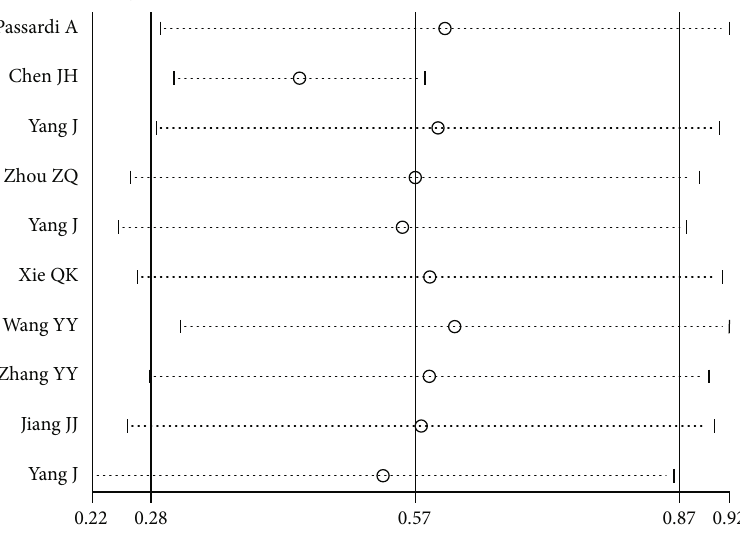
Figure 5: Sensitivity analysis for the association between SII and overall survival. SII: systemic immune-in fl ammation